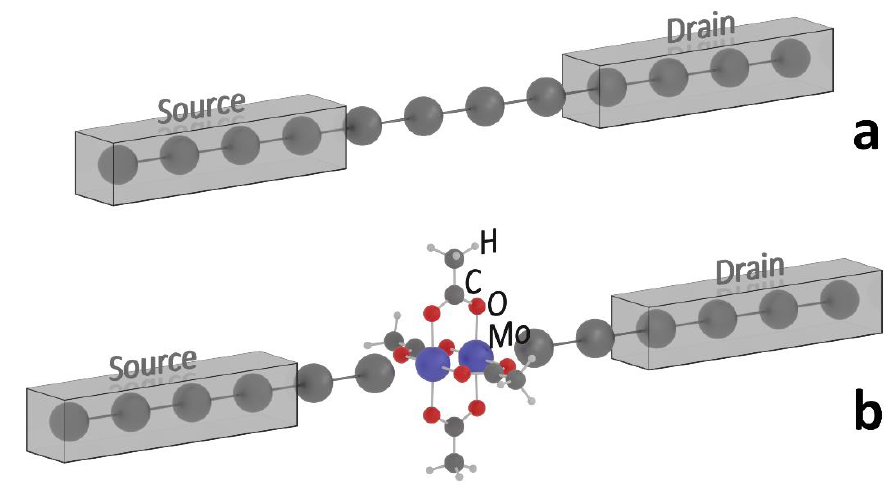
Figure 1. Model systems M 6 – M 6 ( a ) and M 6 – DMT – M 6 ( b ) (M = Li, Al, Ti).